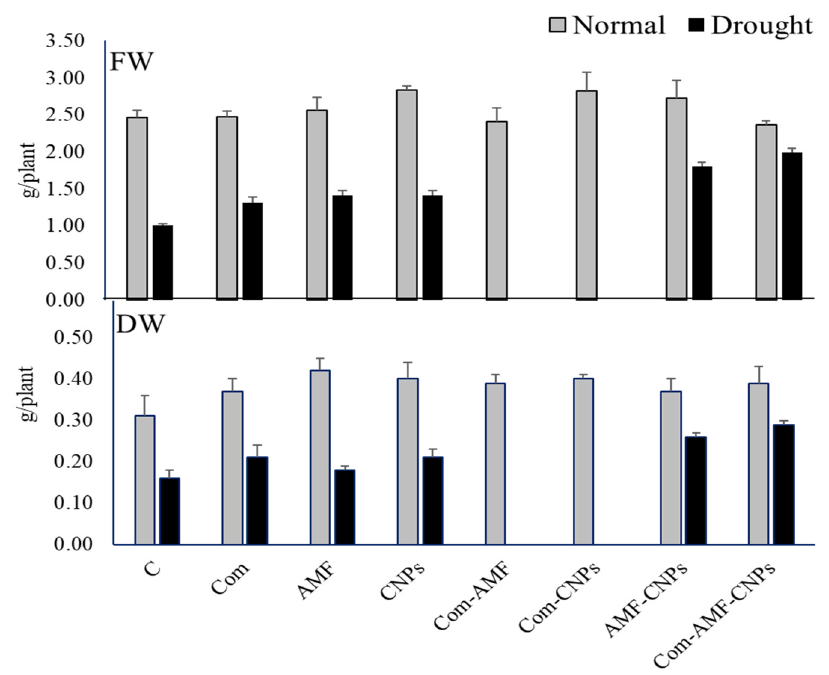
Figure 1. Effect of different treatments on fresh (FW) and dry (DW) weights of maize under control and drought (D) conditions. Different letters indicate statistically significant difference between means for the different treatments at significance level of at least p ≤ 0.05. C: control, Com: compost, AMF: mycorrhiza, CNPs: carbon nanoparticles, D: drought.